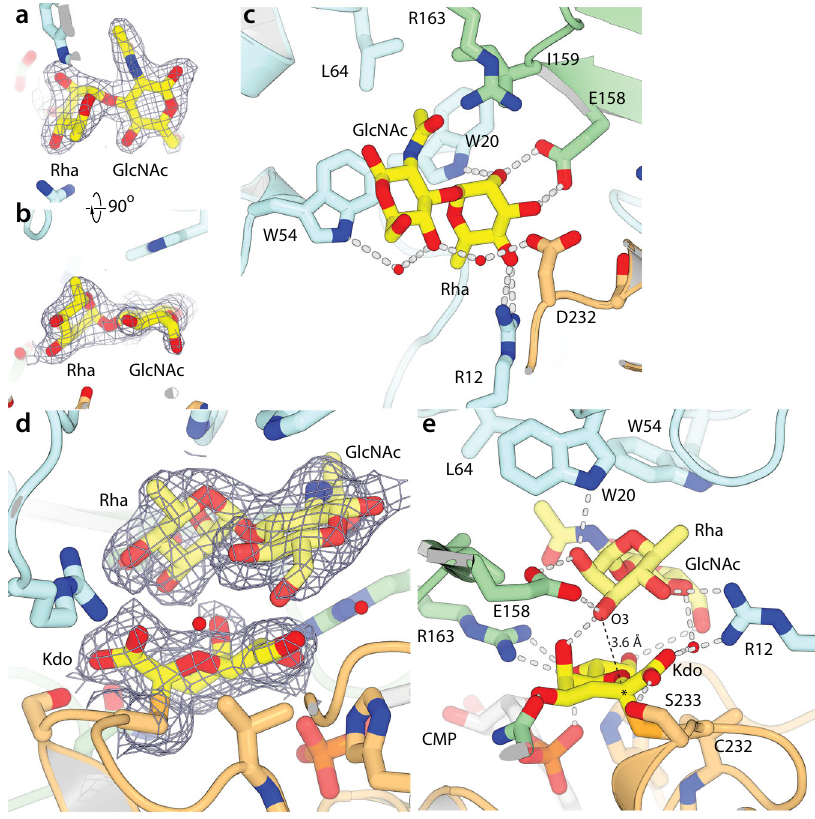
Fig.5|Structuresoftheacceptorandternarycomplexes.a , b Orthogonalviews of the electrondensity (2mFo-DFcmapcontoured at1.0 σ )forthe acceptorbound intheWbbB GT99 activesite. c Detailsoftheinteractionsmediatedbytheacceptorin the active site. d Electron density for the ternary complex, contoured around Cys232, Kdo,and the acceptor(2mFo-DFcmapcontoured at1.0 σ ). e Detailsof